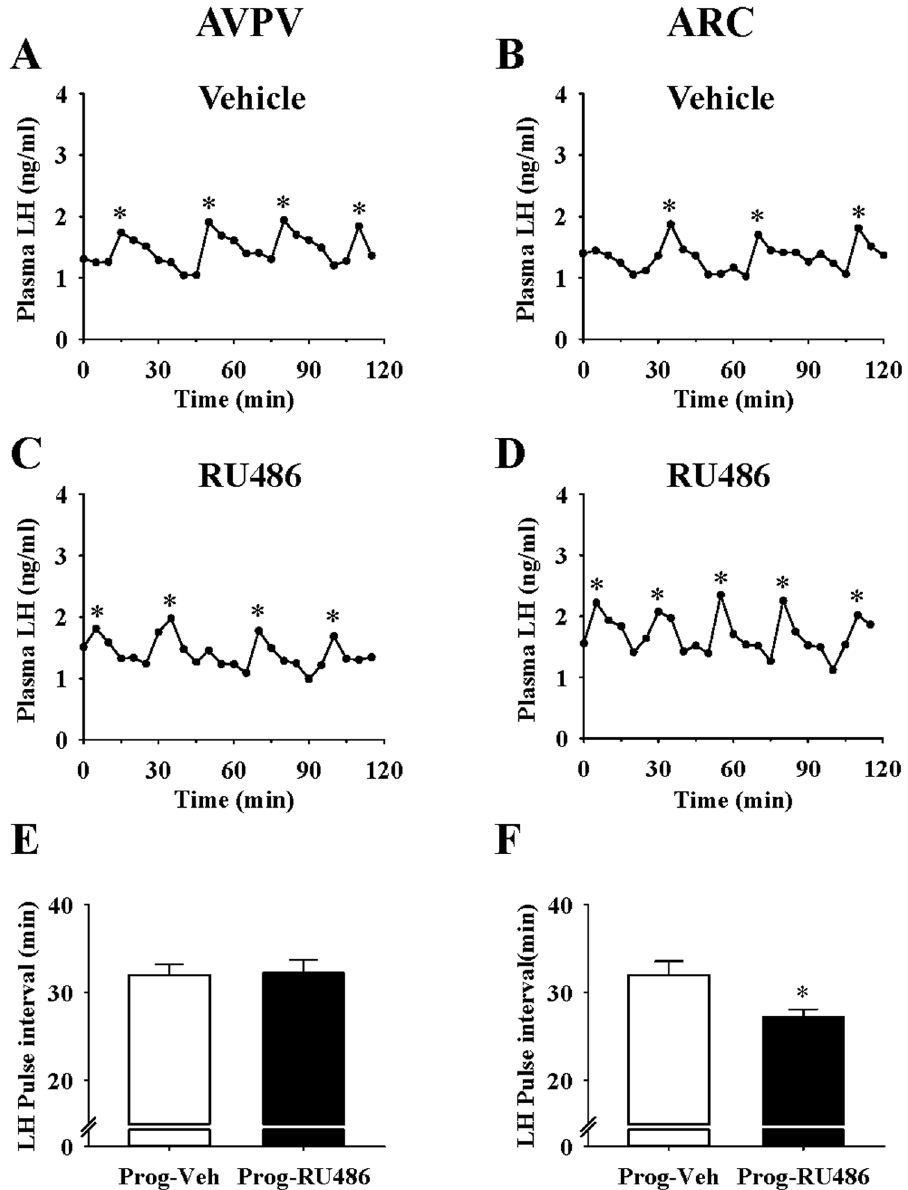
Figure 6. Micro-infusion of RU486 into the ARC, but not the AVPV, reversed the inhibitory effects of intraperitoneal injection of progesterone on LH pulse frequency in female rats. Representative examples illustrating the effects of intra-AVPV administration of vehicle (artificial cerebrospinal fluid/DMSO/ethylene glycol) ( A ) or RU486 ( C ) on LH pulses in progesterone treated animals. ( E ) LH pulse interval was not altered by intra-AVPV administration of RU486 and compared with vehicle. Representative LH profiles illustrating the effects of intra-ARC administration of vehicle ( B ) or RU486 ( D ) in progesterone treated animals. ( F ) Intra- ARC RU486 infusion significantly decreased LH pulse interval compared with vehicle controls. Results are presented as means ± SEM. * P < 0.05, Prog-Veh vs Prog-RU486; n = 6–7 per group. LH pulses are indicated by the asterisk ( *